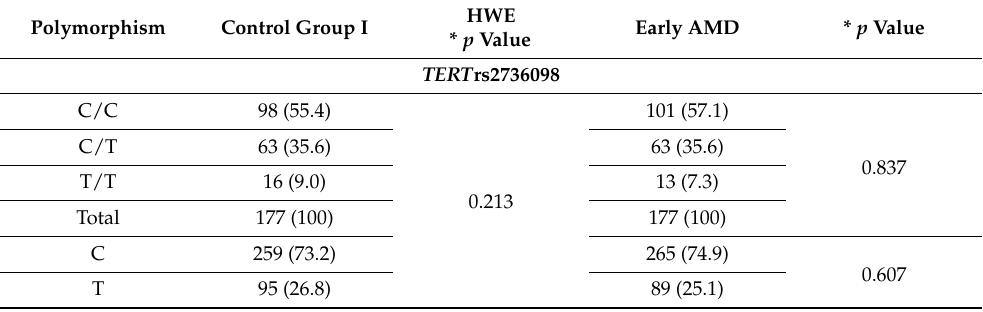
Table 2. Frequencies of genotypes and alleles of TERT rs2736098, rs401681, TRF1 rs1545827, macular degeneration (AMD) and the control